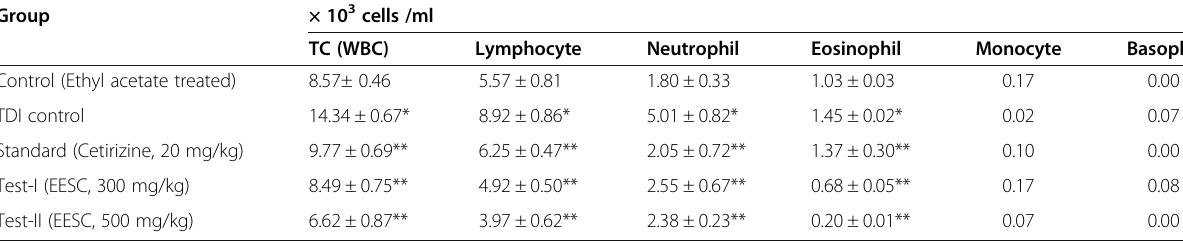
Table 6 Total and differential count of WBC in blood of experimental mice